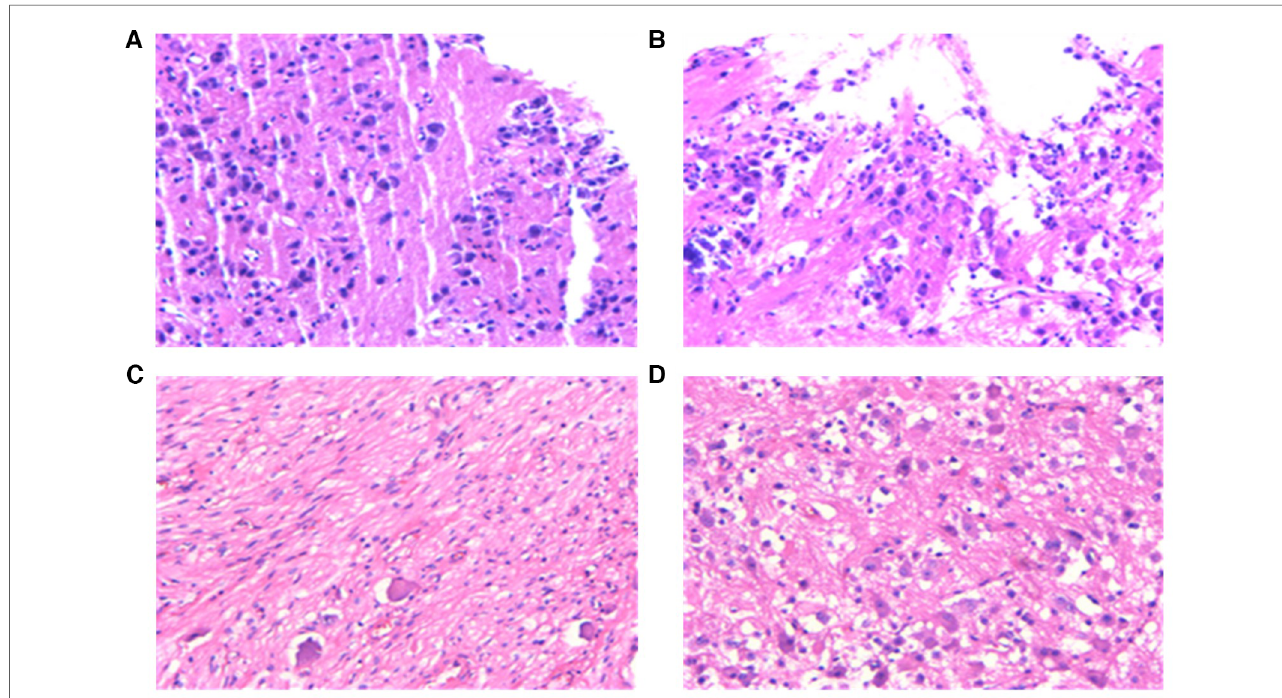
FIGURE 3 Pathological examination results. ( A,B ), pathology of a puncture biopsy specimen from a retroperitoneal tumor: Neuroblasts distributed in sheets were seen against the background of nerve fi bers. The morphology was compatible with developed neuroblastoma with localized calci fi cation, and the pathological diagnosis showed clear extrusion deformation of histiocytes. ( C,D ), pathology of biopsy specimen after surgical resection of tumor: (1) morphology was consistent with neuroblastoma (differentiated) with focal calci fi cation. (2) retroperitoneal adrenal neuroblastoma (differentiated) with focal calci fi cation, MKI<2%. 3) tumor tissue was found in lymph nodes (aside from renal vein) (6/7). Tumor tissue was found in lymph nodes (aside from the abdominal aorta) (2/2). No tumor cells were discovered in lymph nodes (0/1) and